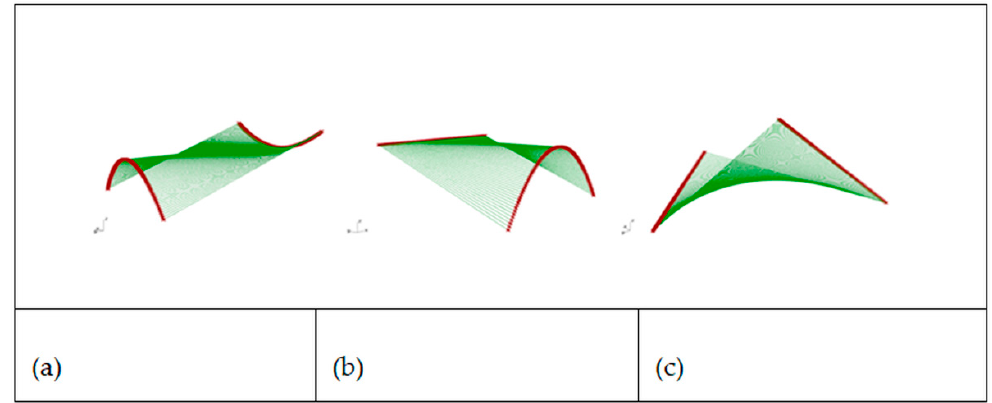
Figure 2. Typical examples of Catalan surfaces; respectively from the left: ( a ) a cylindroid; ( b ) a conoid; ( c ) a hyperbolic paraboloid.